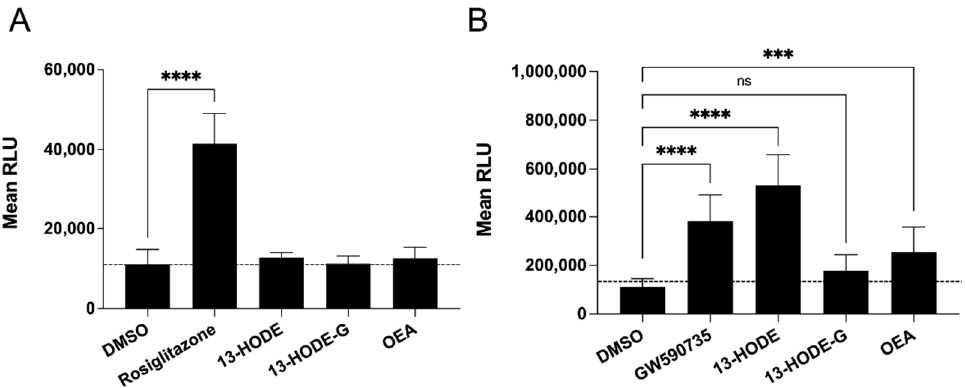
Figure 10. Impact of 13-HODE and 13-HODE-G on PPAR activity. Cells were incubated with 30 µ M 13-HODE, 13-HODE-G, or OEA overnight and PPAR activity was measured using the PPAR assay kits according to the manufacturers’ instructions. Rosiglitazone (10 µ M) and GW 590735 (100 nM) were utilized as positive controls for the ( A ) PPAR- γ and ( B ) PPAR- α assays, respectively. Data represent the mean ( ± SEM) of three (PPAR- γ ) or five (PPAR- α ) experiments, each performed in triplicates. p values were obtained by performing a 2-way ANOVA with a Sidak multiple comparison tests. **** p < 0.0001, *** p < 0.001. ns: p > 0.05.